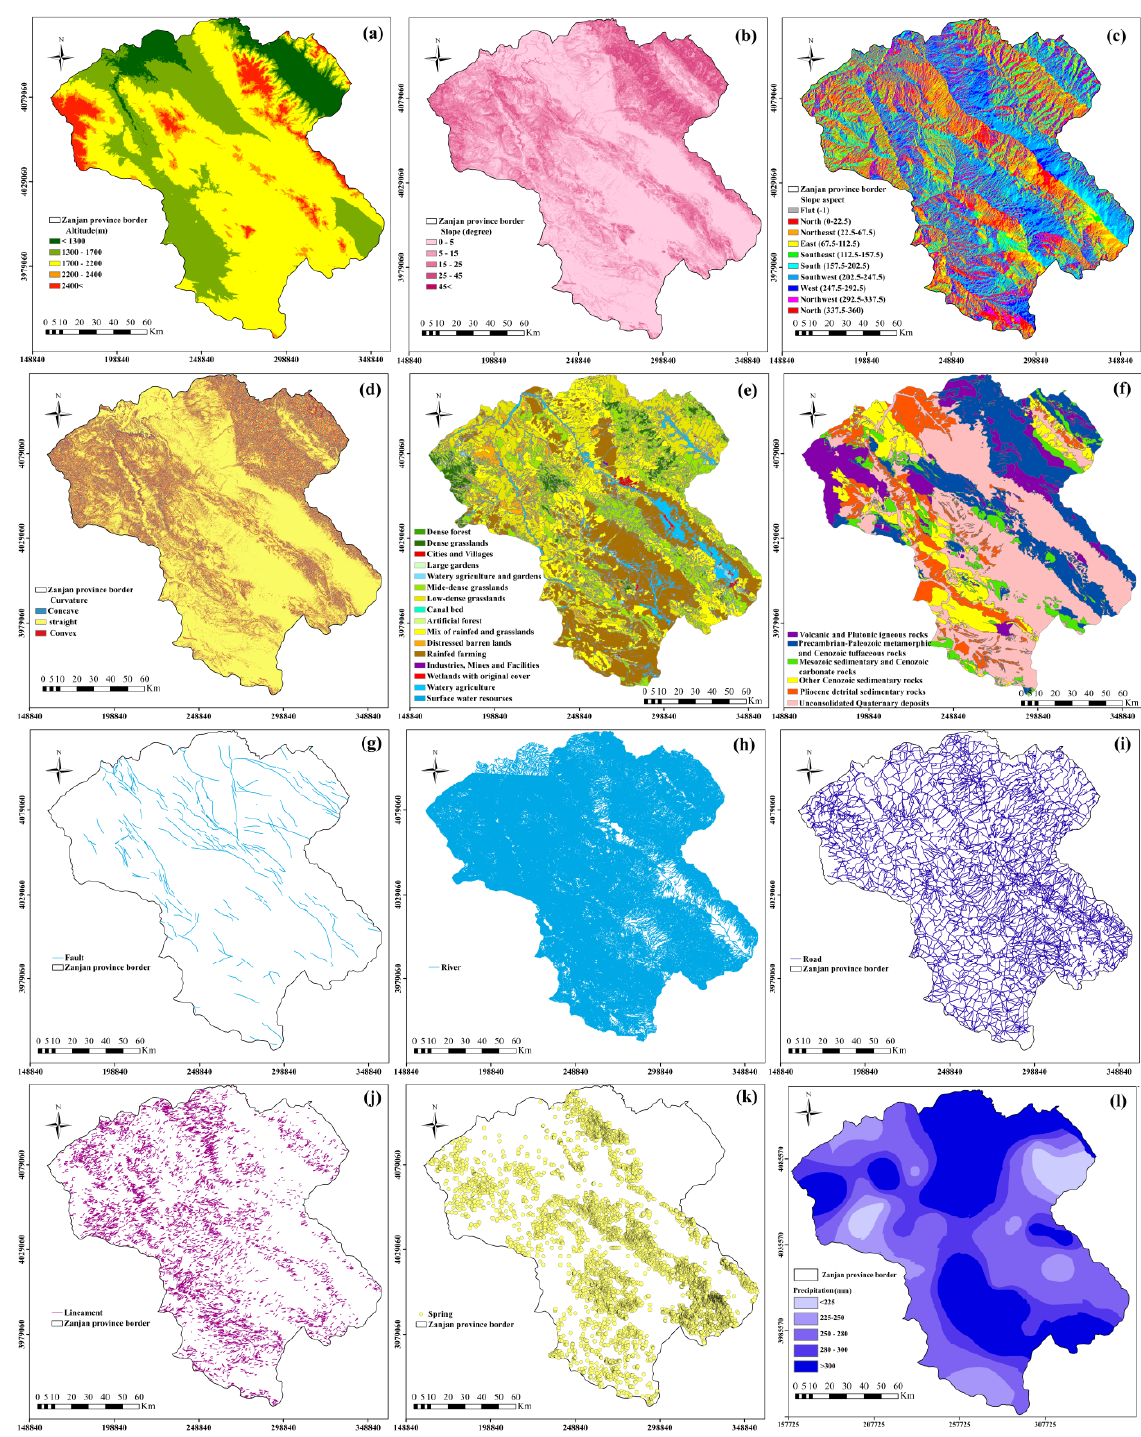
Figure 3. Spatial layers of landslide factors, showing: ( a ) map of the altitude, ( b ) map of the slope, ( c ) map of the slope aspect, ( d ) map of the topography curvature, ( e ) map of the land use, ( f ) map of the lithology structure, ( g ) map of the faults, ( h ) map of the river, ( i ) map of the roads, ( j ) lineaments, ( k ) map of the springs, ( l ) precipitation map.